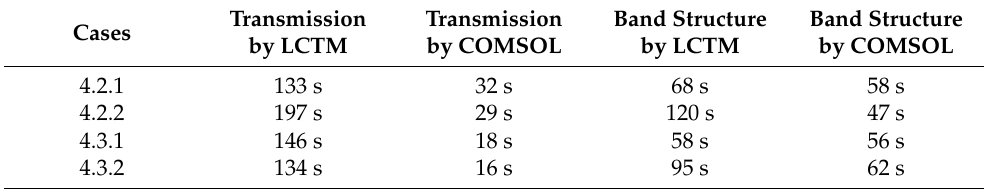
Table 6. CPU times by using the proposed LCTM + ABC and FEM + ABC in Sections 4.2 and 4.3.